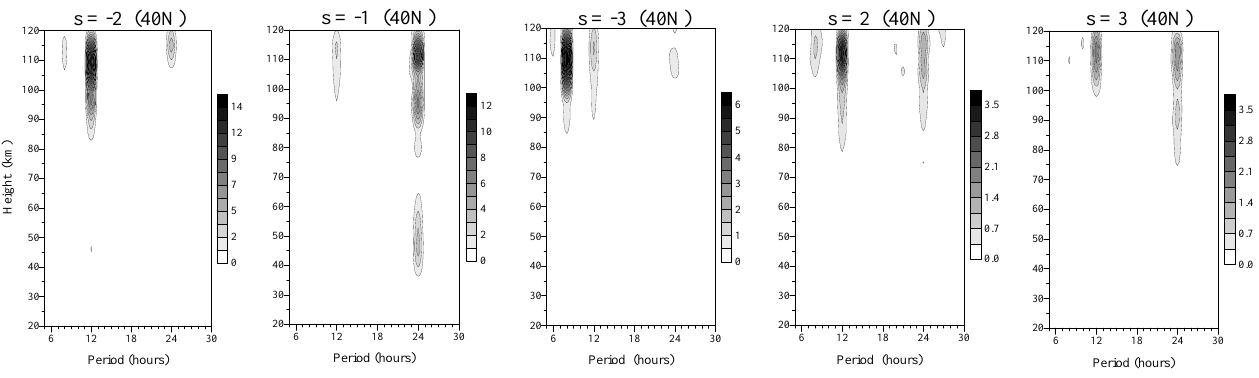
Figure 1 Fig. 1. Average (2002–2007) altitude spectra of the tidal components at latitude of 40 ◦ N; only zonal wavenumbers for which the non- migrating semidiurnal components are well evident are presented, i.e. westward propagating tides with s = − 1 and s = − 3 and eastward propagating one with s = 2 and s =